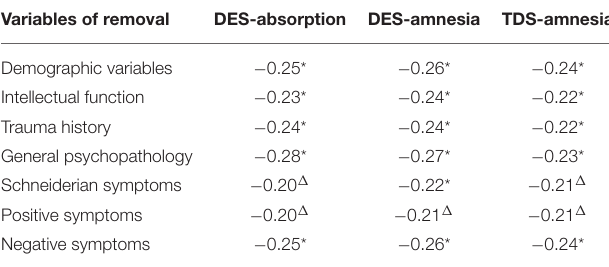
TABLE 4 | Partial correlations between the source judgment of participant-generated items and dissociation subscales. Variables of